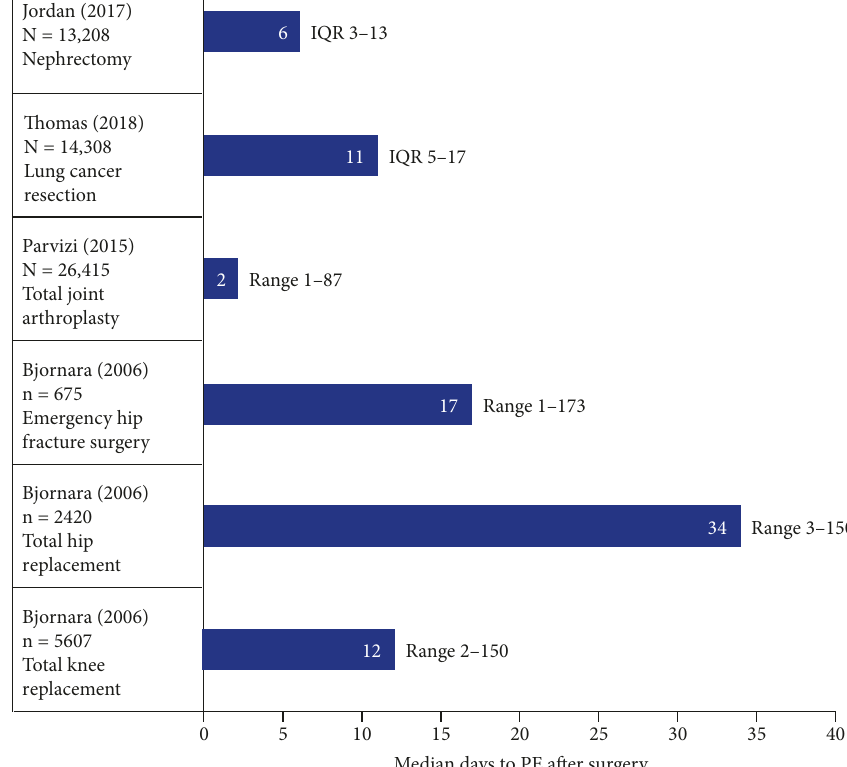
Figure 3: Median days to pulmonary embolism (PE) in large surgery populations. IQR = Interquartile range. Data from Jordan et al.